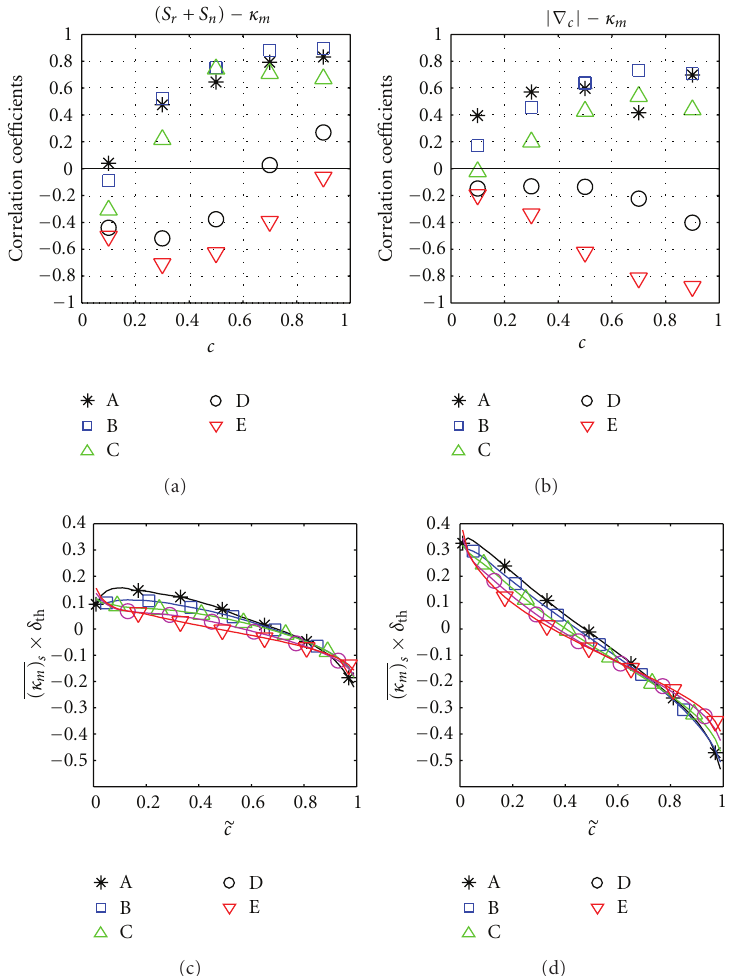
Figure 4: Correlation coe ffi cients between (a) ( S r + S n ) and κ m , and between (b) |∇ c | and κ m correlations on c = 0.1, 0.3, 0.5, 0.7, and 0.9 isosurfaces for cases A–E. Variation of ( κ m ) s × δ th with (cid:2) c across the flame brush for (c) Δ = 8 Δ m ≈ 0 . 8 δ th and (d) Δ = 24 Δ m ≈ 2 . 4 δ th for cases